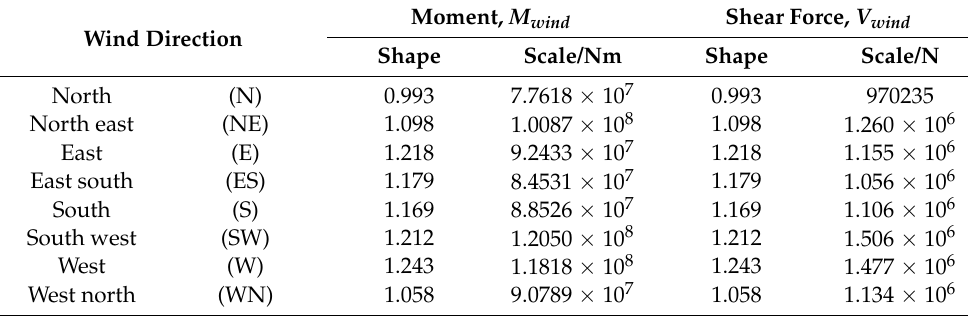
Table 2. Characteristic values (shape and scale parameter) of shear force, V wind , and the moment, M wind , using an FE model and considering the soil–pile